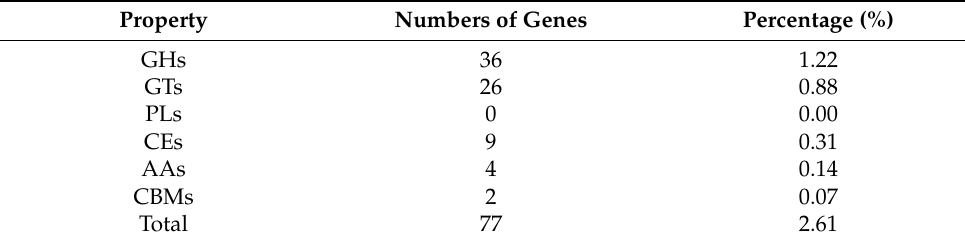
Table 3. Analysis of CAZy in L. paracasei